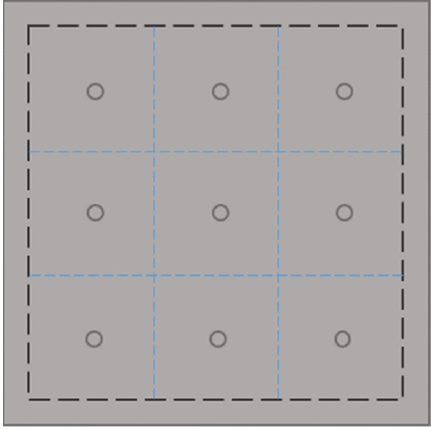
Figure 4. Nozzles arrangement.